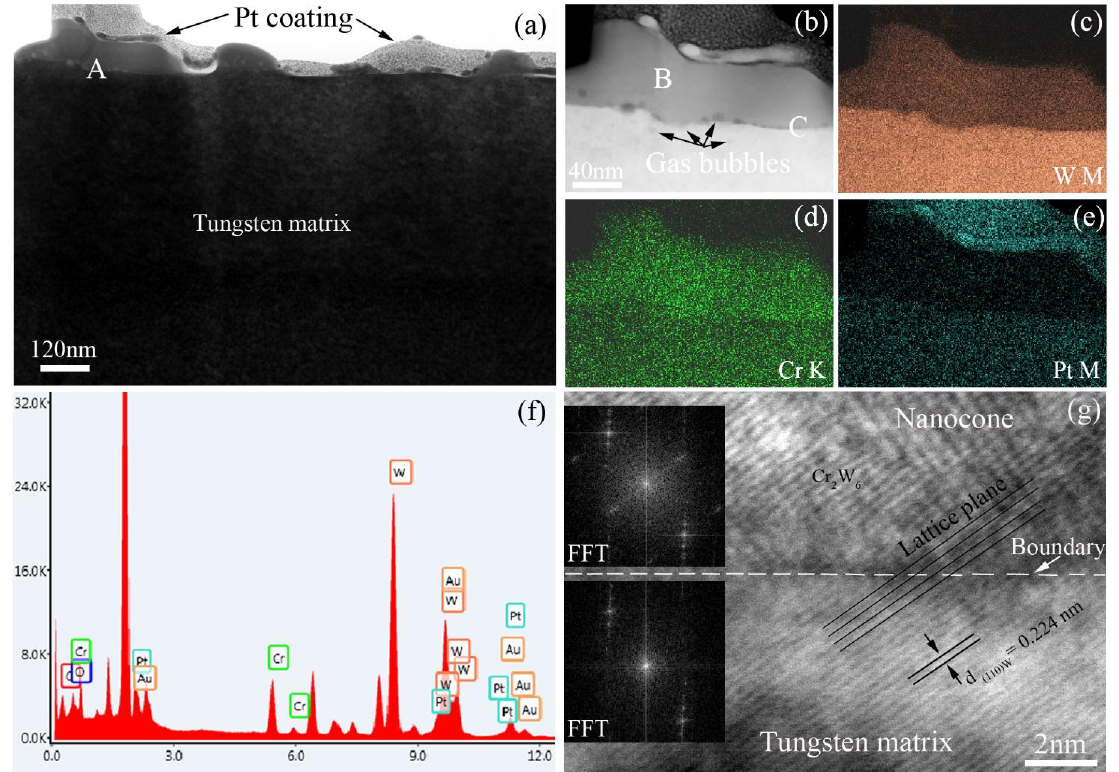
Figure 6. ( a ) Bright field scanning transmission electron microscopy (STEM) image showing the microstructure of the self-assembly nanocones on the irradiated tungsten surface annealed for 3 h; ( b ) High-angle annual dark field STEM image of the nanocone; ( c – e ) Element mappings of W M, Cr K and Pt M, respectively; ( f ) Energy dispersive spectrometer (EDS) results of the nanocone; ( g ) High-resolution transmission electron microscopy (TEM) image of the crystal boundary between tungsten matrix and the